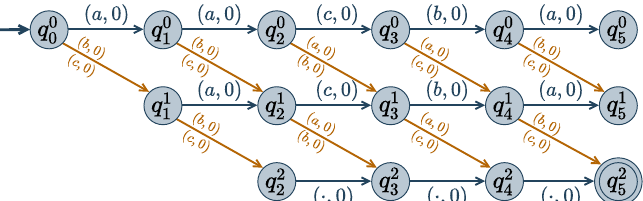
Figure 3. Weighted automaton representing D IST ( X , t , H , δ ) where X is a set of 5 variables, with domains D i = { a , b , c } , t = aacba , H represents the Hamming distance, and δ is set to 2. State q d means that values X 1 . . . X i are such that H ( X 1 . . . X i , t [ X 1 . . . X i ]) = d (or (cid:62) δ if d = δ ). A labeled ( v , w ) −→ q (cid:48) means ∆ ( q , v , q (cid:48) ) = w , i.e., there is a transition from q to q (cid:48) with value v and weight w . arrow q